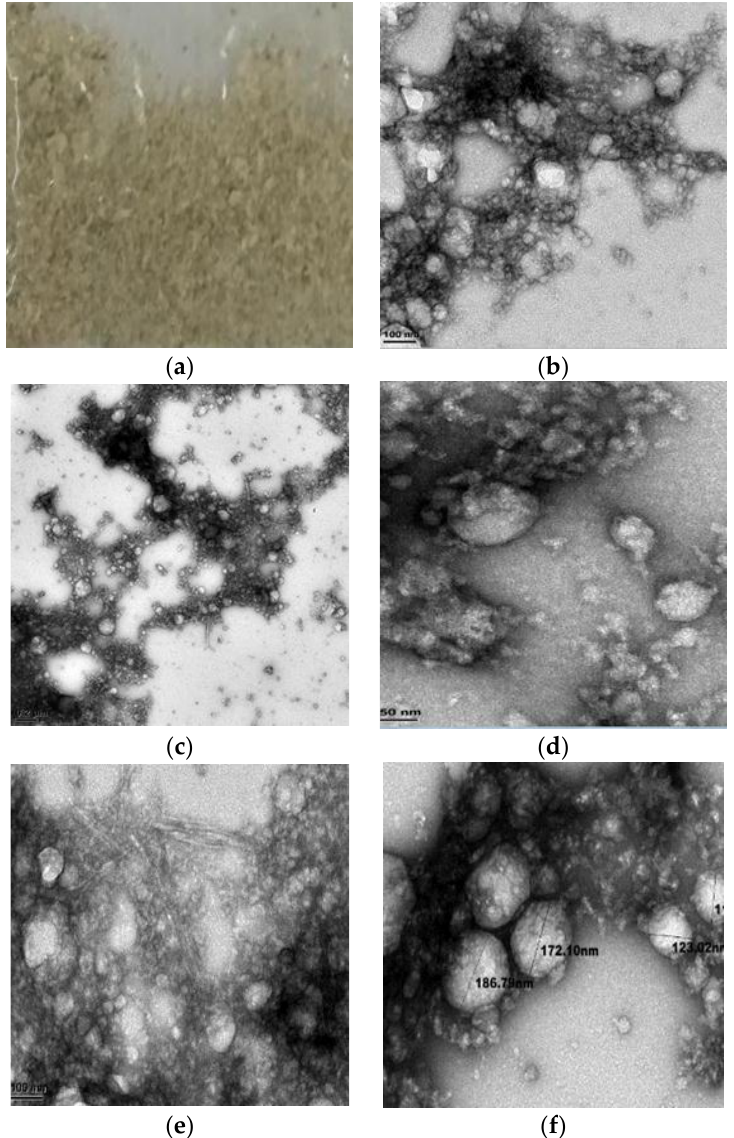
Figure 1. Structural characteristics of ( a ) unmagnified ACM; ( b ) ACM at 0.2 microns; ( c ) ACM-stabilized 30 mL ( w / w ) soya milk emulsion at 100 nm with thread-like fibers; ( d ) ACM-stabilized 30 mL ( w / w ) soya milk emulsion at 100 nm; ( e ) ACM-stabilized 50 mL ( w / w ) soya milk emulsion at 50 nm; ( f ) ACM-stabilized 50 mL ( w / w ) soya milk emulsion at 100